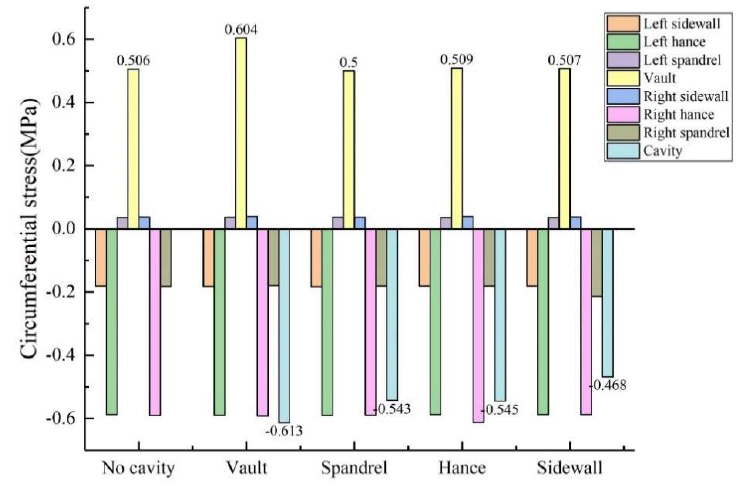
Figure 10. Variation of circumferential stress with void location.